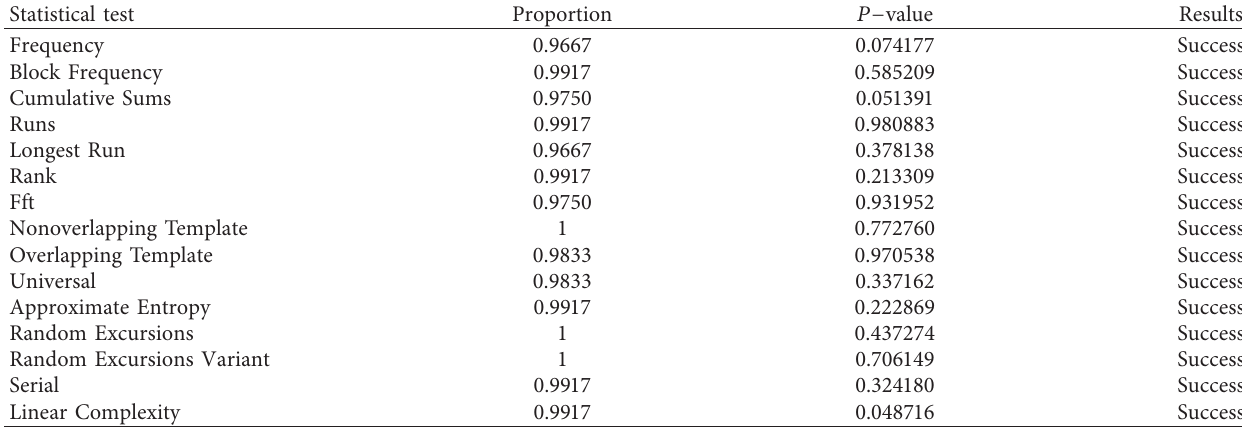
Figure 4: Flow diagram of PRNG design. Table 2: The results of NIST test suite.